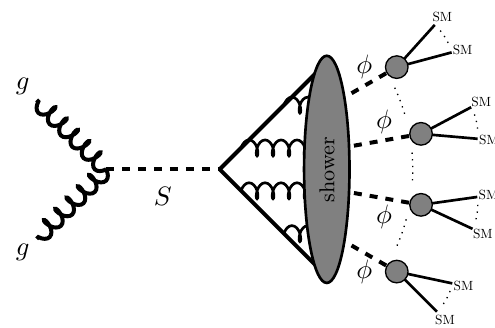
Figure 2. Schematic gluon fusion production of the mediator, S , followed by quasi-conformal showering and (cid:30) decay, generating a heavy soft bomb event. If the Higgs is the mediator, production may also occur through vector boson fusion or with an associated vector boson, and with identical showering and